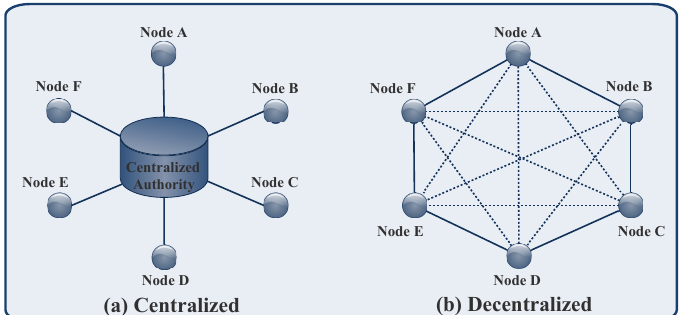
Figure 2. Centralized and decentralized